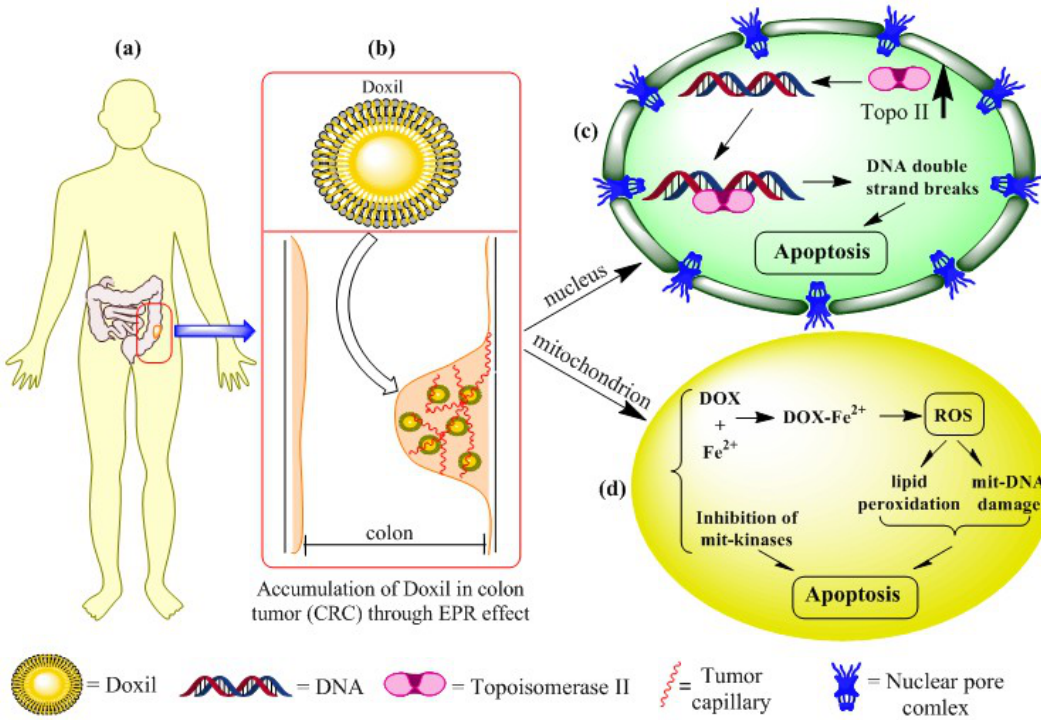
Fig. 1. schematic illustration of colorectal cancer and Doxil mechanisms, (a) colorectal cancer, (b) accumulation of Doxil in colon tumor, (c) molecular mechanism of Doxil in the nucleus, increase of topoisomerase II,induced by Doxil, causes more DNAbreaking which subsequently leads to apoptosis, (d) molecular mechanism of Doxil in the mitochondria, Fe 2+ -conjugated Doxil causes ROS production which consequently induces apoptosis. On the other hand, Doxil inhibites the mitochondrial kinases, resulting in apoptosis induction.